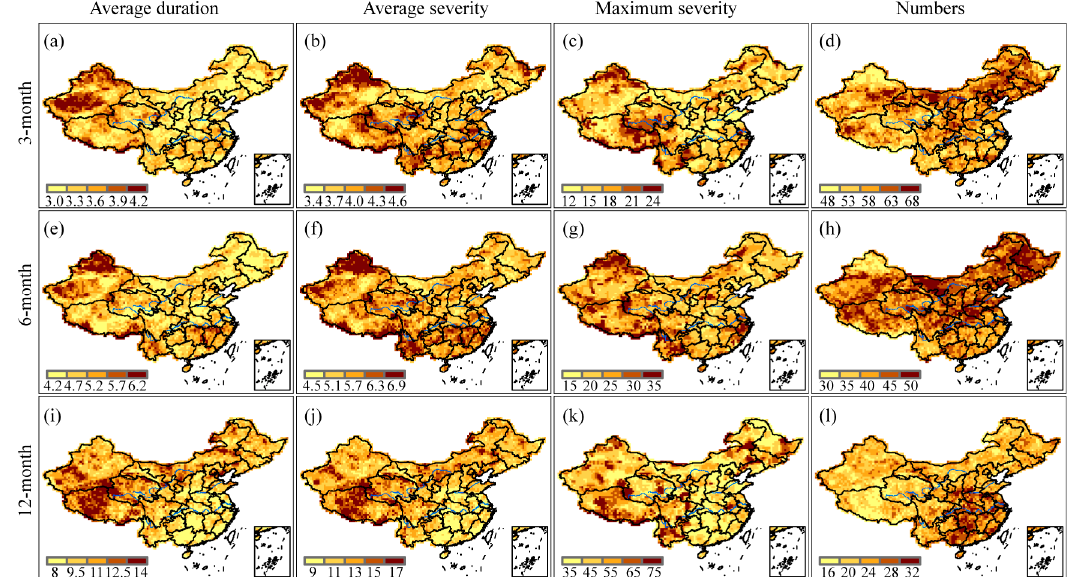
Figure 3. Spatial patterns of average duration, average severity, maximum severity, and the num- ber of drought episodes derived from SPI-3, SPI-6, and SPI-12 values, respectively. Specifically, ( a , e , i ) indicate the average drought duration; ( b , f , j ) represent the average drought severity; ( c , g , k ) refer to the maximum drought severity; ( d , h , l ) denote the total number of drought events.